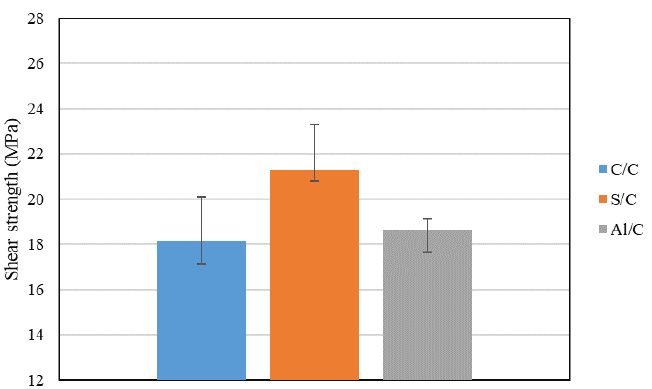
Figure 15. Effect of dissimilar adherend on single lap joint shear strength. Adapted from [42]. Another approach consists of locally recessing the adherends [135] (see Figure 16b), which creates a peak of the peel stress in the adhesive at the point where the recess was made, but one that is lower than the peak peel stress at the edge of the overlap, and, thus allows for a more uniform use of the available overlap length [136]. In this case, the depth of the recess seems to be the most effective parameter and not the length [136]. The effect of chamfering was numerically studied by Moya Sanz [136], including the effect of the chamfer angle upon the adherend, the adhesive or both. Schematic designs of this configuration are shown in Figure 16c–e), respectively. The best-performing configuration had both adherends and the adhesive chamfered at an angle of